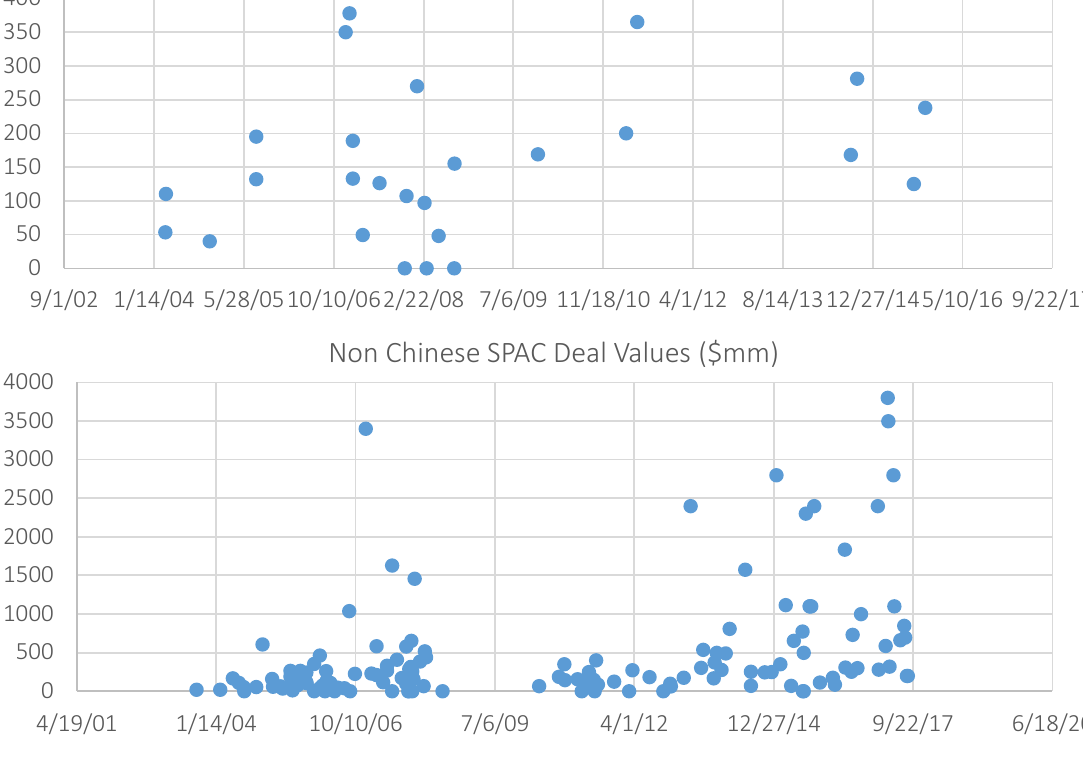
Figure 6. SPACs’ deal